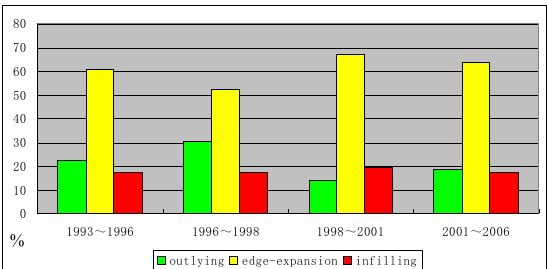
Figure 2. Areas of three urban expansion types in different peri- ods